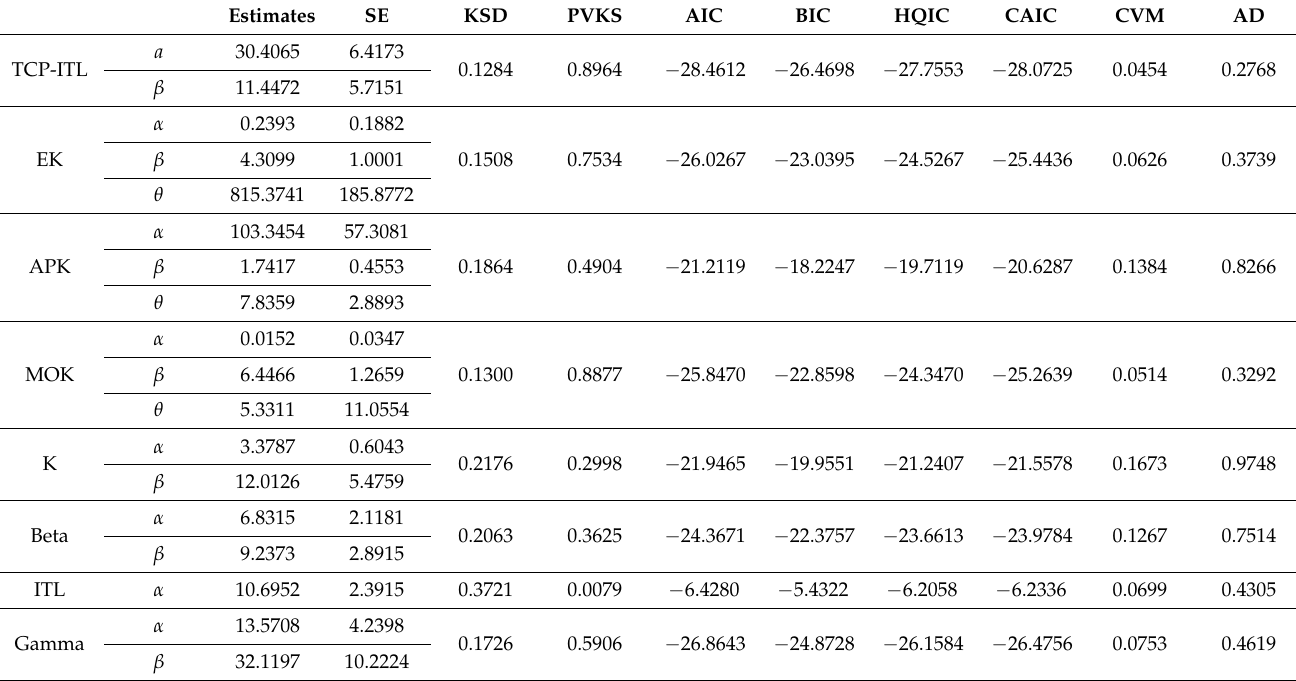
Table 11. MLE and different measures for each model of the flood level data III.